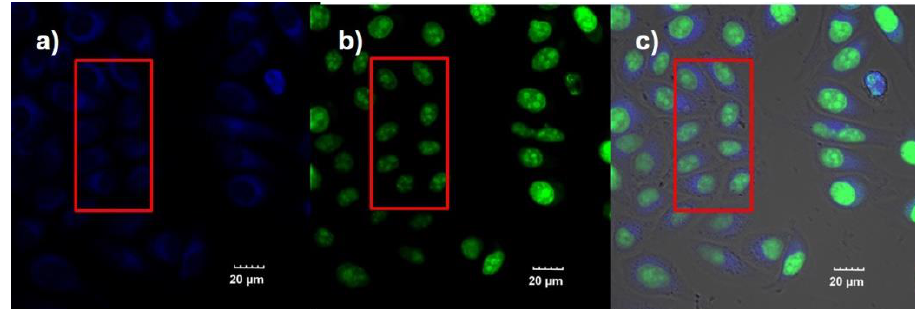
Figure 7. Subcellular localization of P in Hela cells. ( a ) cells supplemented with Cu 2+ 10 µ M) for 30 min, followed by the incubation with P 10 µ M) for 30 min; ( b ) cells treated upon addition of Cu 2+ (10 µ M) for 30 min, P (10 µ M) for another 30 min, and then cultured with Green 488 for 30 min; ( c ) images of overlay in panel ( a , b ).